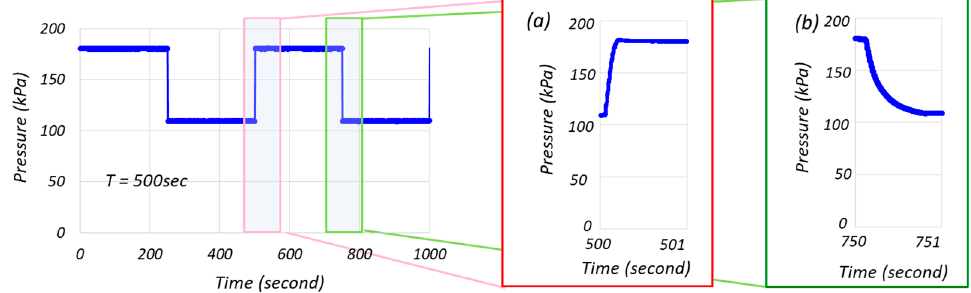
Figure 4. The performance of pressure control during periodic hydrostatic pressure. ( a ) A close view of the pressure increasing period. ( b ) A close view of the pressure decreasing